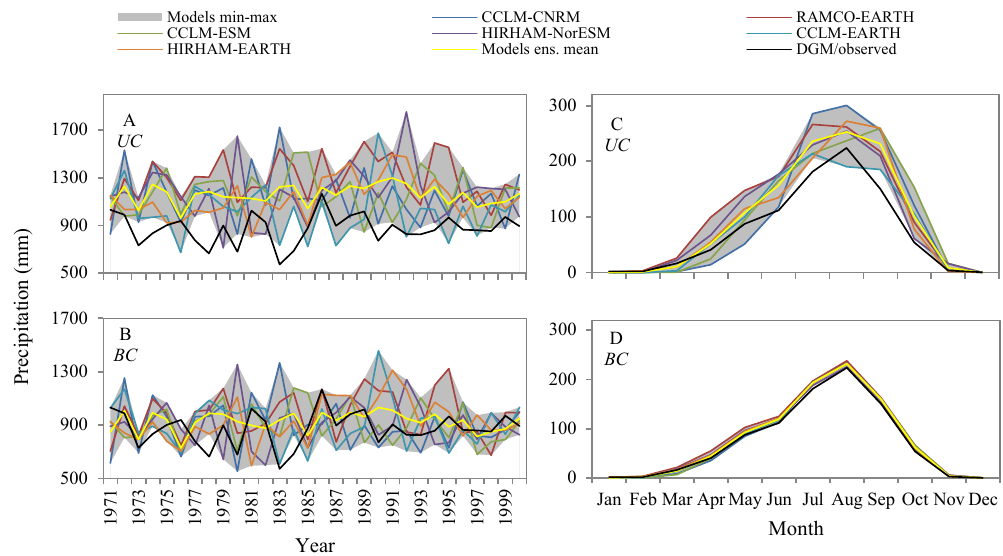
Figure 4. Historical mean annual (a, b) and mean monthly (c, d) precipitation. UC refers to non bias corrected, BC to bias corrected. The P factor equals 50, 80, 50, and 50% for (a) – (d) , respectively. The R factor equals 4.3, 3.2, 0.6, and 0.11 for (a) – (d) , respectively.